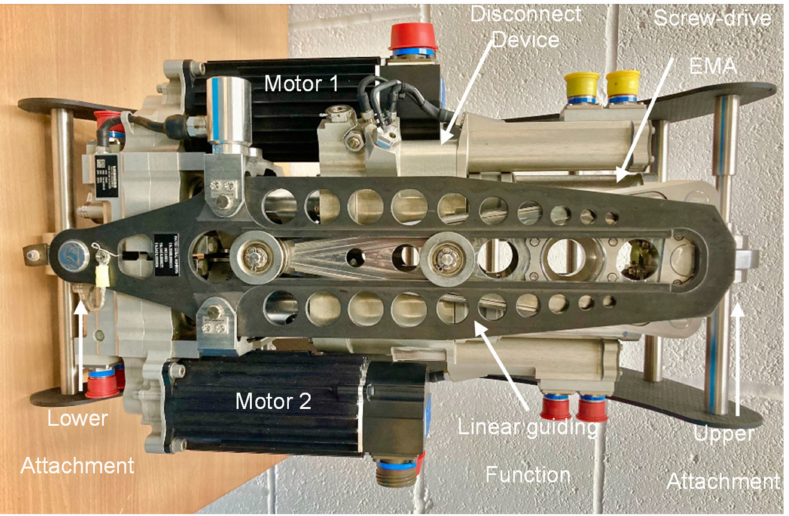
Figure 1. Helicopter electromechanical actuation